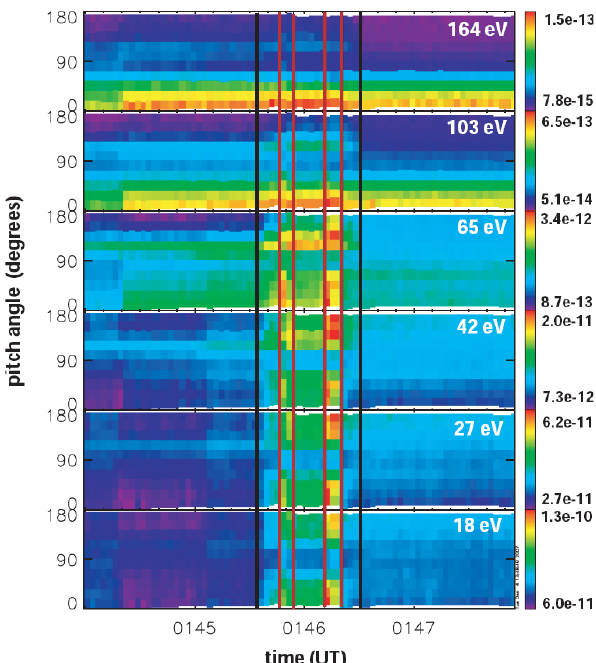
Fig. 4. Electron pitch angle spectrograms for EESA-L energy chan- nels 18, 27, 42, 65, 103, and 164eV. The data are presented in the solar wind rest frame. Two pairs of solid red lines bound the current sheet crossings while the solid black lines show the estimated loca- tions of the separatrices. The color coding indicates the amplitude of the distribution functions in units of s 3 km − 3 cm − 3 .